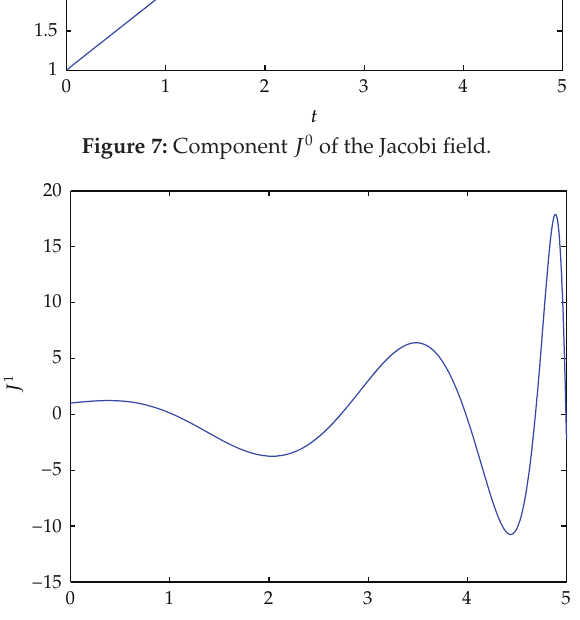
Figure 8: Component J 1 of the Jacobi